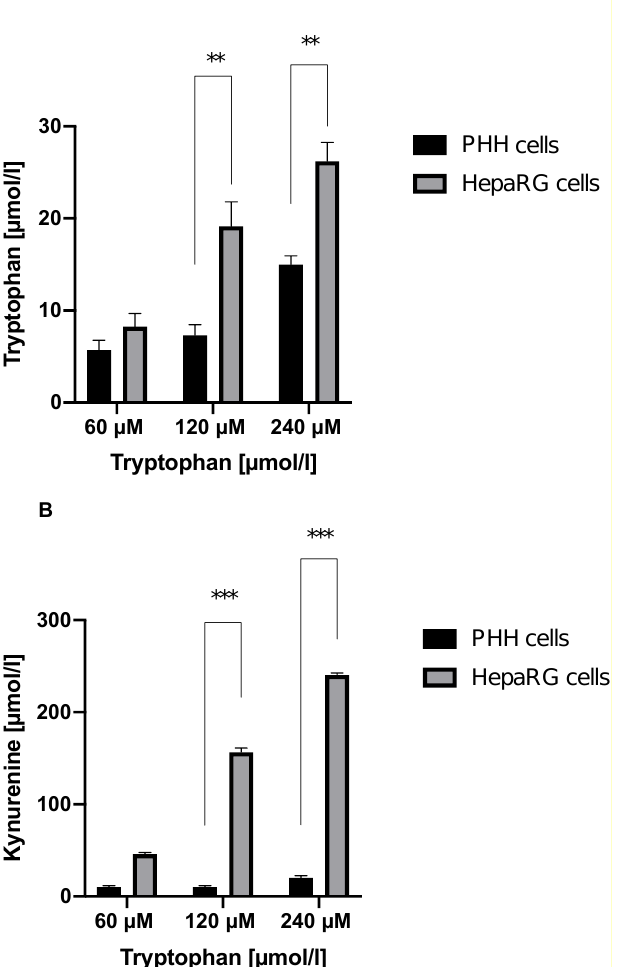
Figure 2. Trp degradation and Kyn accumulation in different hepatocytes at 72 h. ( A ) The comparison of Trp degradation between PHH cells and HepaRG cells. ( B ) The comparison of Kyn accumulation between PHH cells and HepaRG cells. ** p < 0.01, and *** p < 0.001.